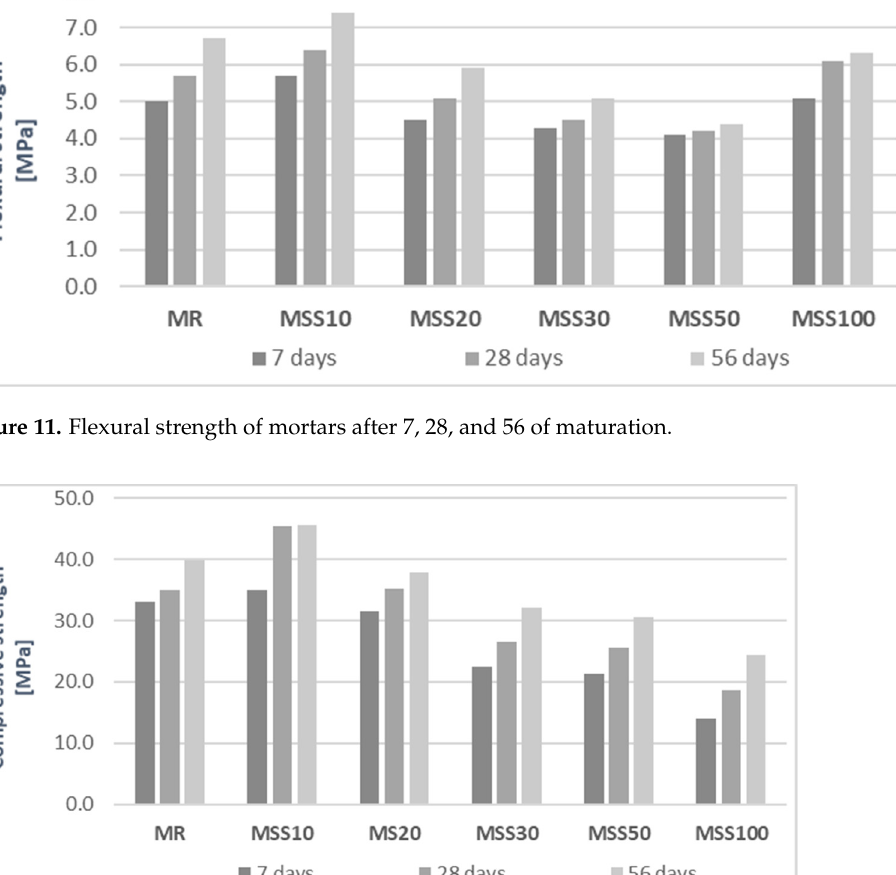
Figure 11. Flexural strength of mortars after 7, 28, and 56 of maturation.